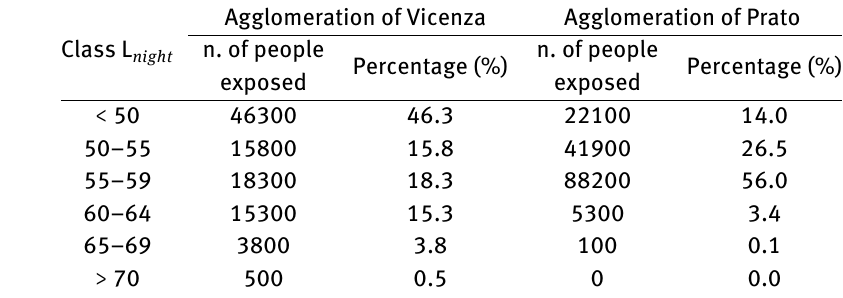
Figure 5: Flowchart for the elaboration of Noise Action Plans given by UNI/TR 11327